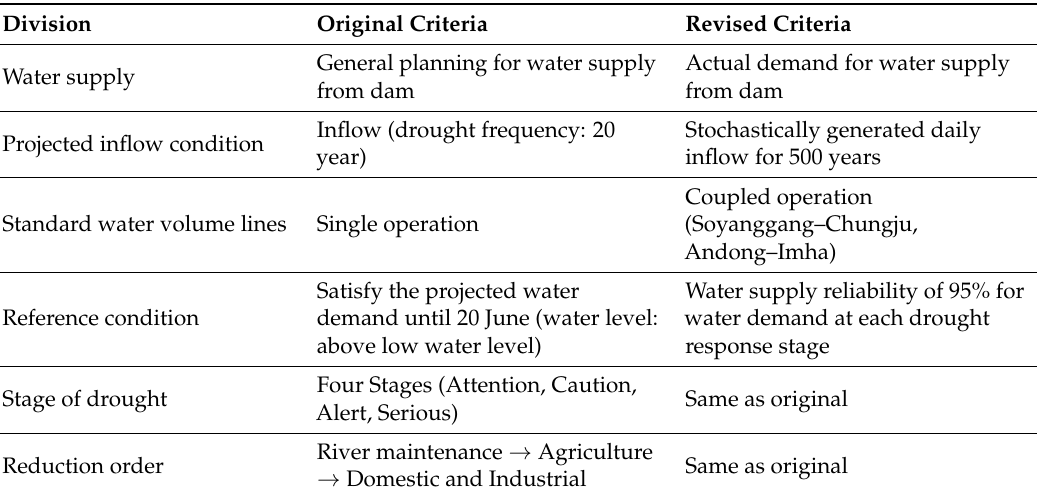
Table 1. Improvements to method of setting standard daily water volume